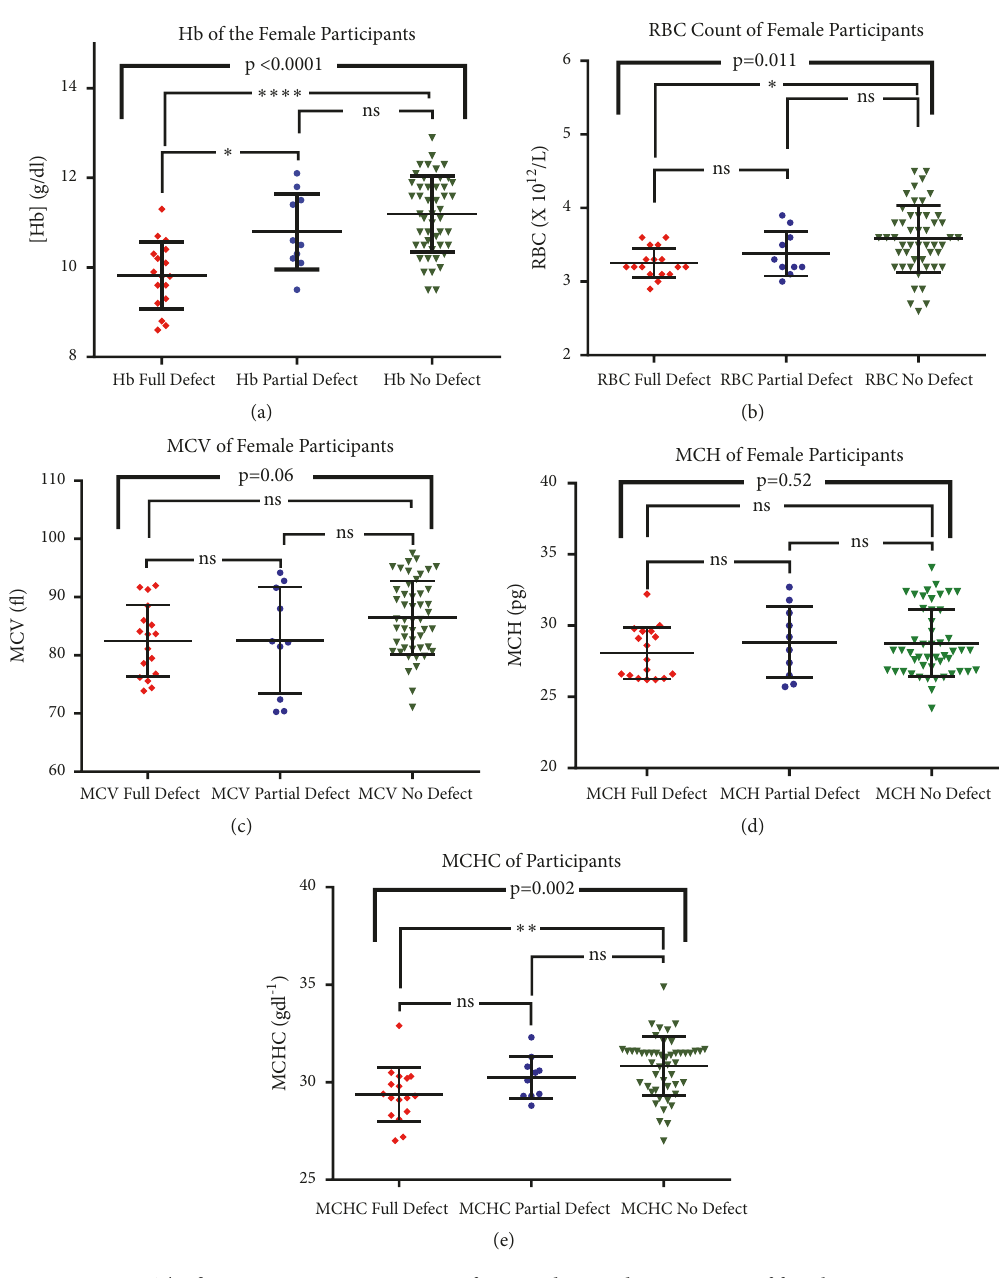
Figure 5: The figure represents comparison of RBC indices and G6PD status of female